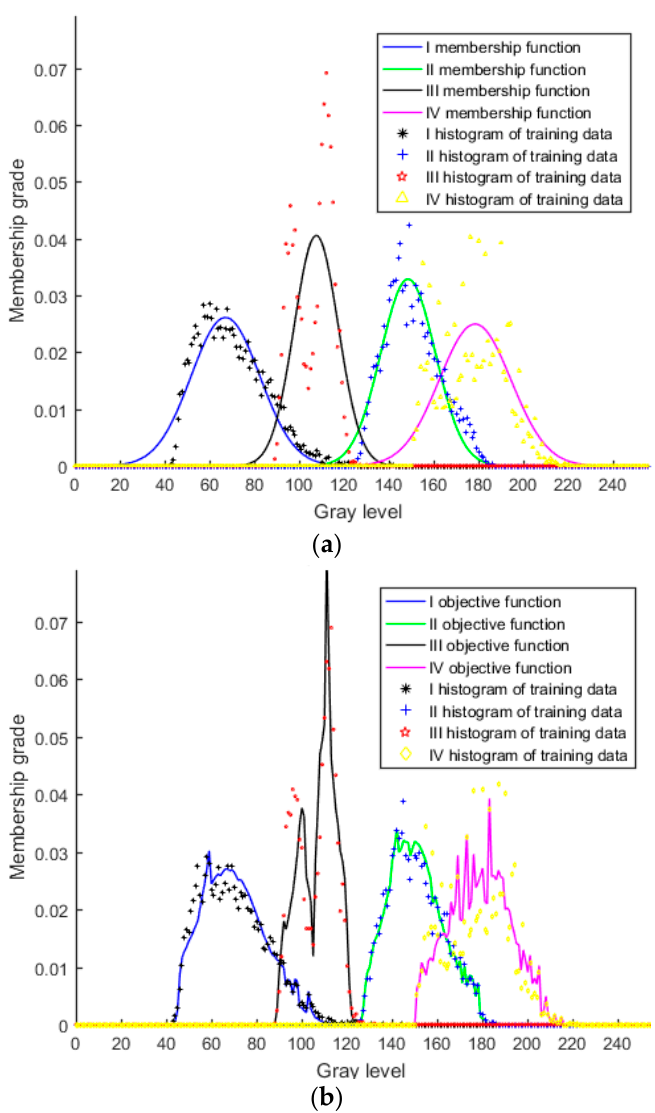
Figure 8. Quick Bird synthetic image of training data histogram and best classification model. ( a ) Type-1 fuzzy membership function model; and, ( b ) Best classification decision model deviation.